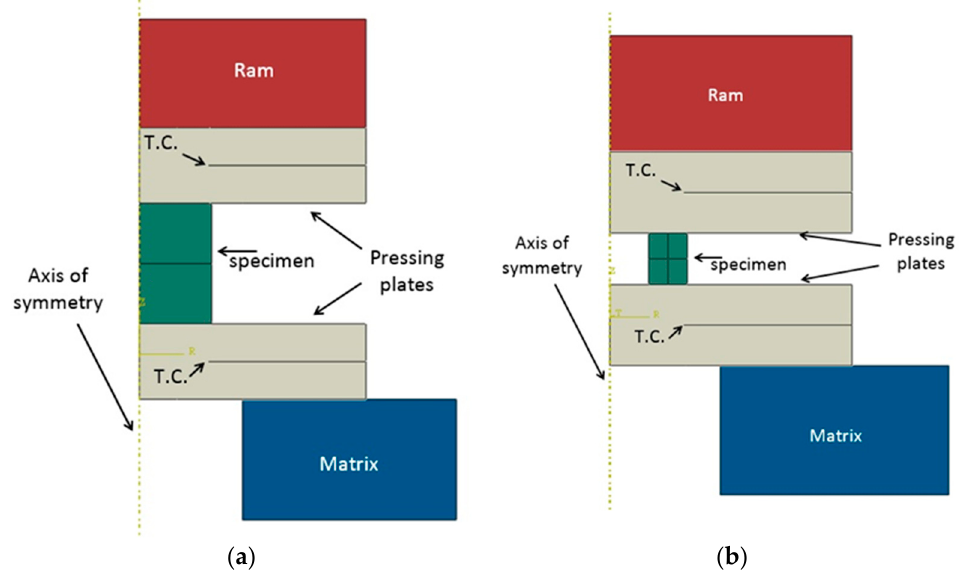
Figure 2. An finite element (FE) geometric model of the upsetting process of the ( a ) cylindrical and ( b ) ring upsetting specimens with T.C. indicating the thermo-couple locations.